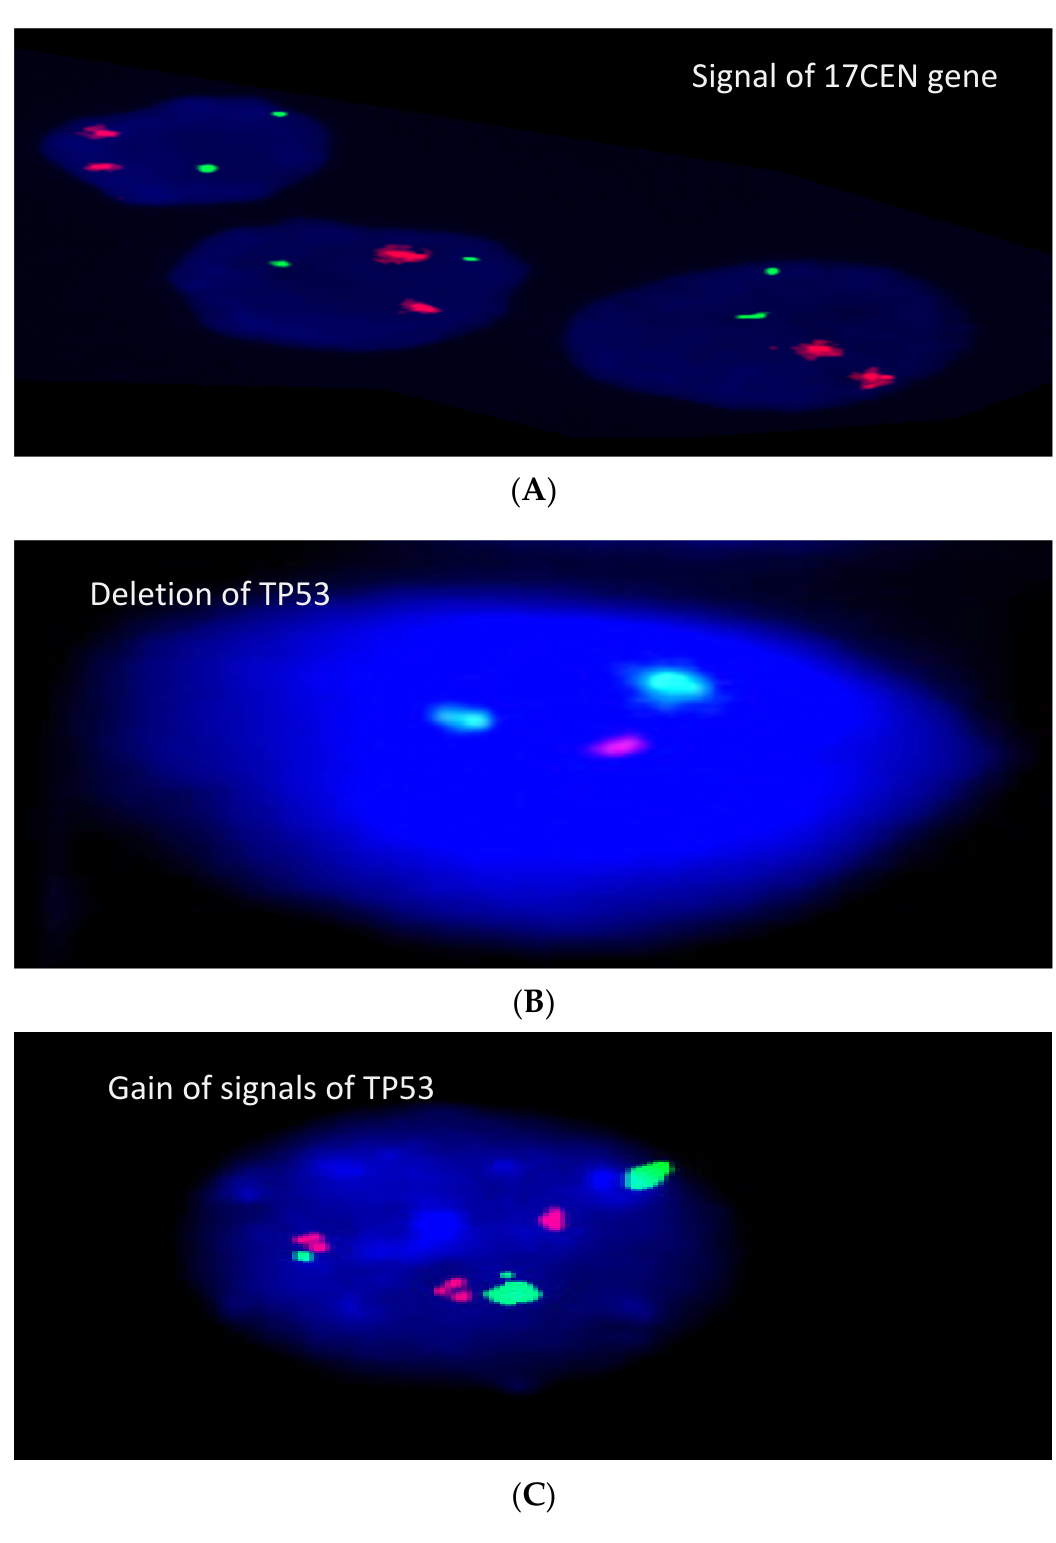
Figure 2. Result of FISH analysis. ( A ) represents a normal result (2 green and 2 red signals). ( B ) TP53 deletion (2 green and 1 red signals). ( C ) represents cases with trisomy singles (3 green and 3 red).